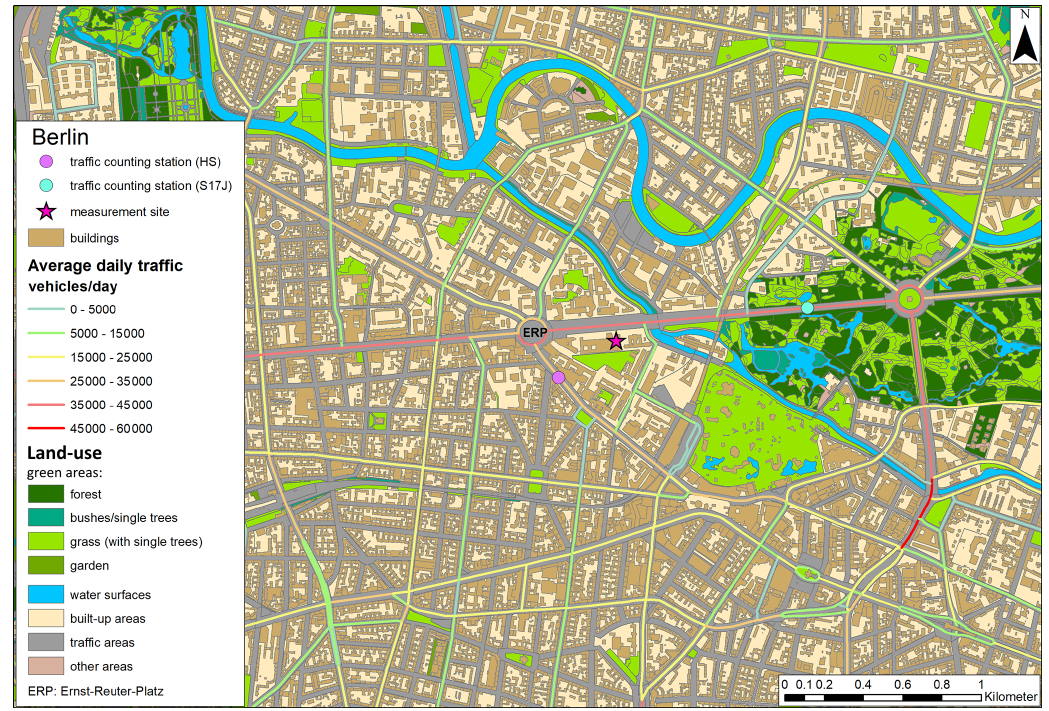
Figure 1. Eddy-covariance measurement site in central Berlin near Ernst-Reuter-Platz (ERP; data sources: Geoportal Berlin, 2014 (modified), 2021; Umweltatlas Berlin,